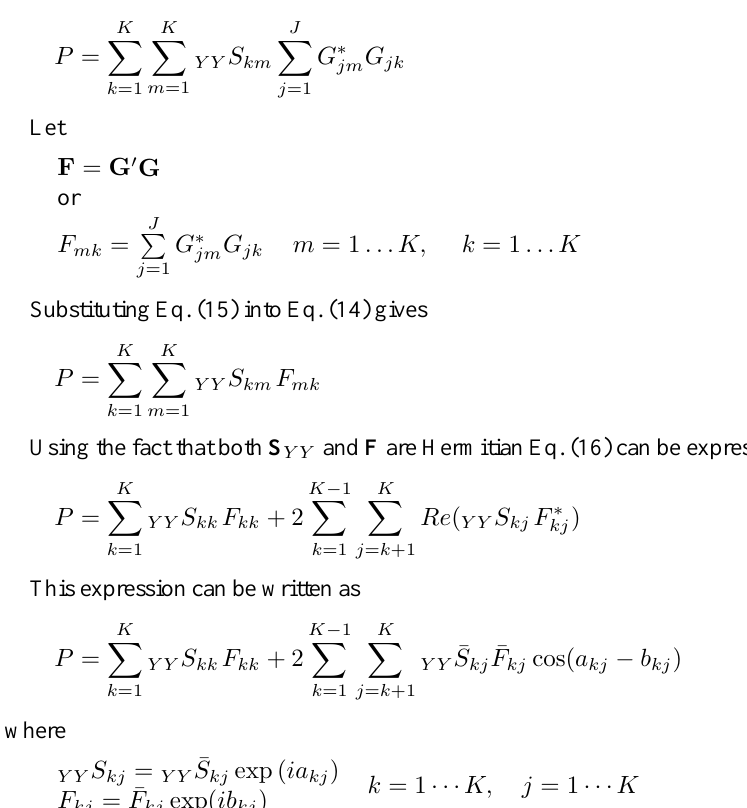
Fig. 12. Example 3, Beam frequency response